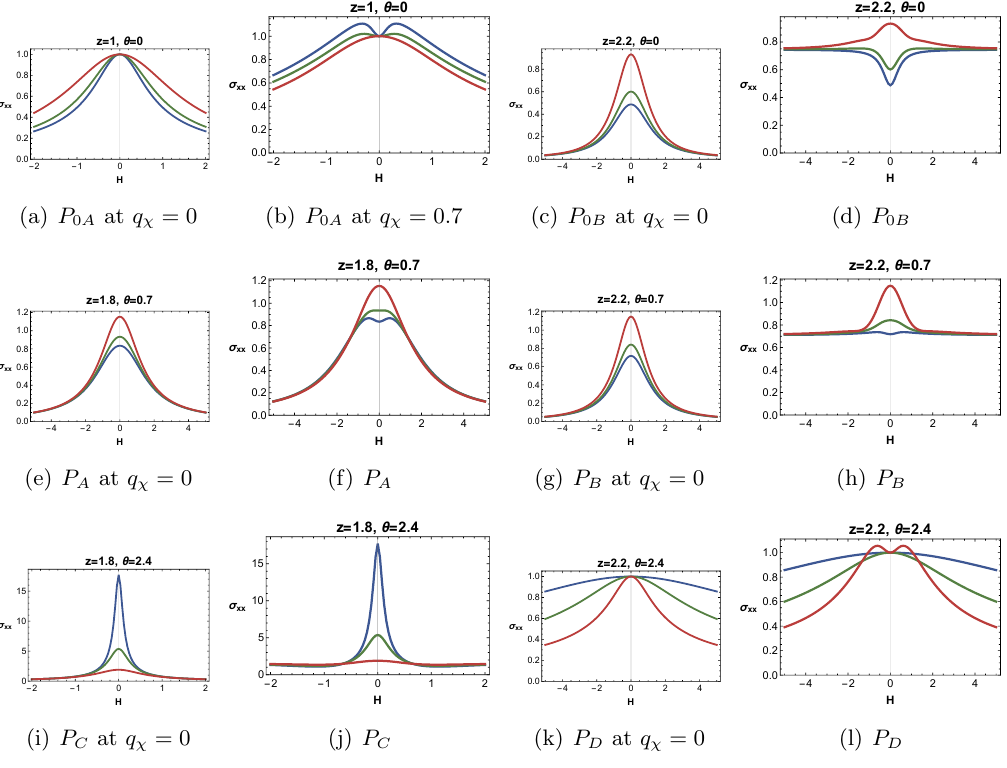
Figure 6 . Temperature evolution for (cid:27) xx ( H ) for di(cid:11)erent ( z; (cid:18) ). Each curves corresponds to T = 0 : 04 ; 0 : 1 ; 0 : 24 for blue, green, and red respectively. We used q (cid:31) = 0 : 7 for all non-zero q (cid:31) case.